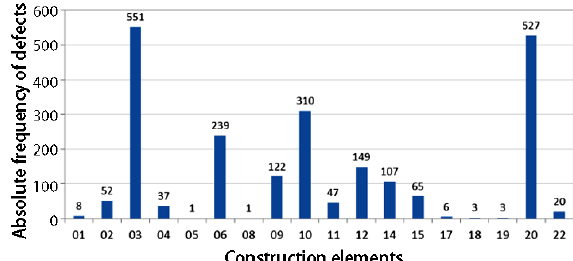
Fig. 12. Absolute frequency of defects in concrete elements